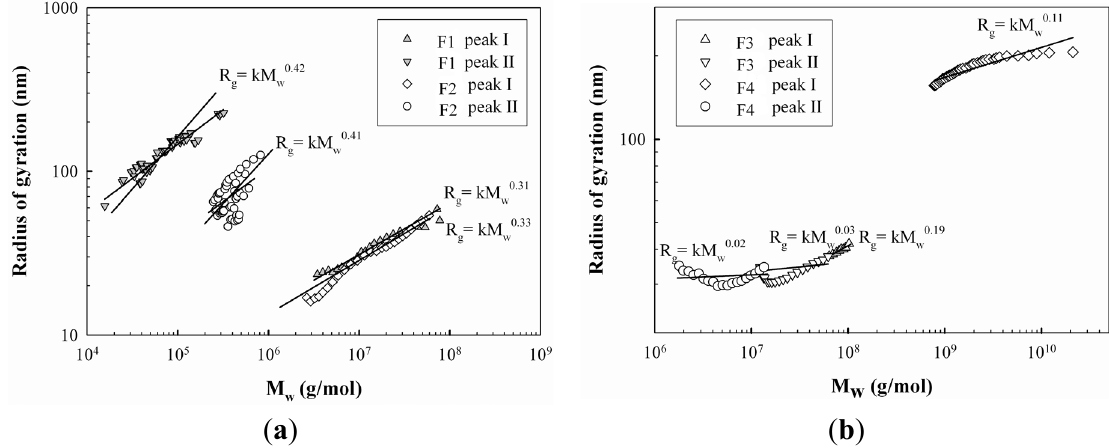
Figure 2. The plot of weight average molecular weight (M proteoglycans: F1, F2, F3, and